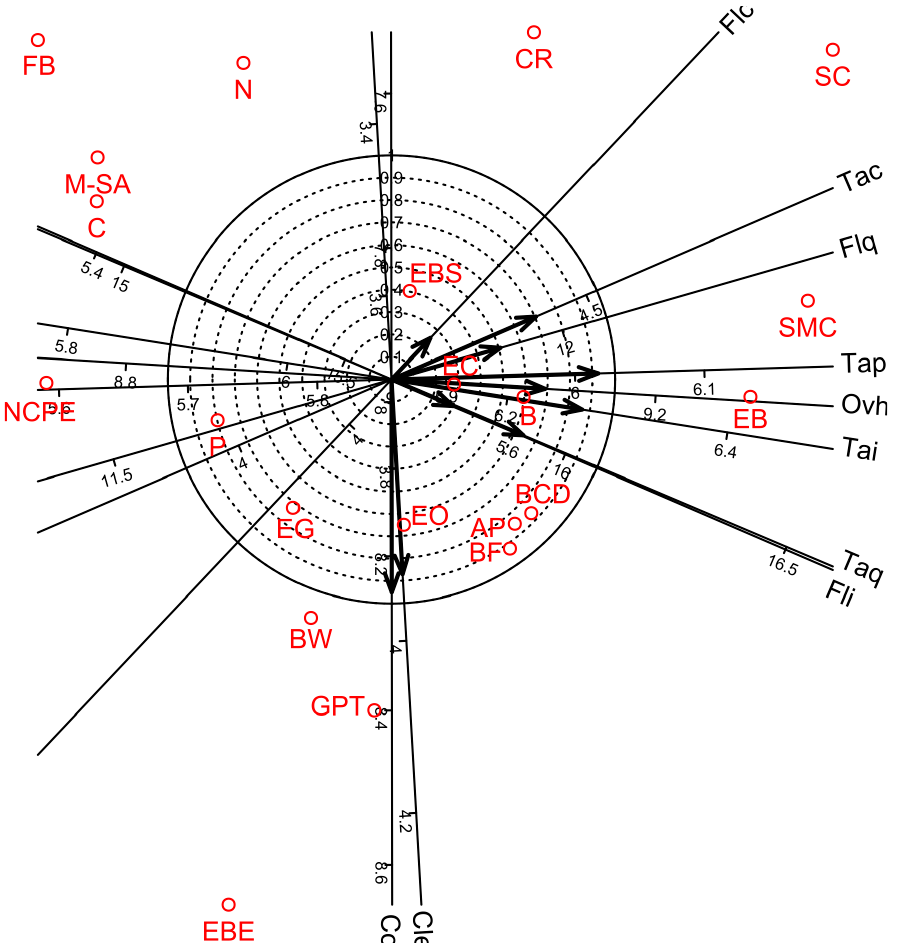
Figure 4. Biplot diagrams of Factor 1 versus Factor 2 of Principal Axis Factor Analysis (Iterated Principal Factor) conducted for ten organoleptic parameters of white wine samples in twenty-one bentonite product treatments (Debrecen-Pallag, Hungary). Organoleptic parameters are Cle: Clearness, Col: Colour, Fli: Flavor intensity, Flc: Flavor character, Flq: Flavor quality, Tai: Taste intensity, Tac: Taste character, Taq: Taste quality, Tap: Taste persistency, Ovh: Overall harmony. Explanations for bentonite product name abbreviations (red colour) are given in Table 1.